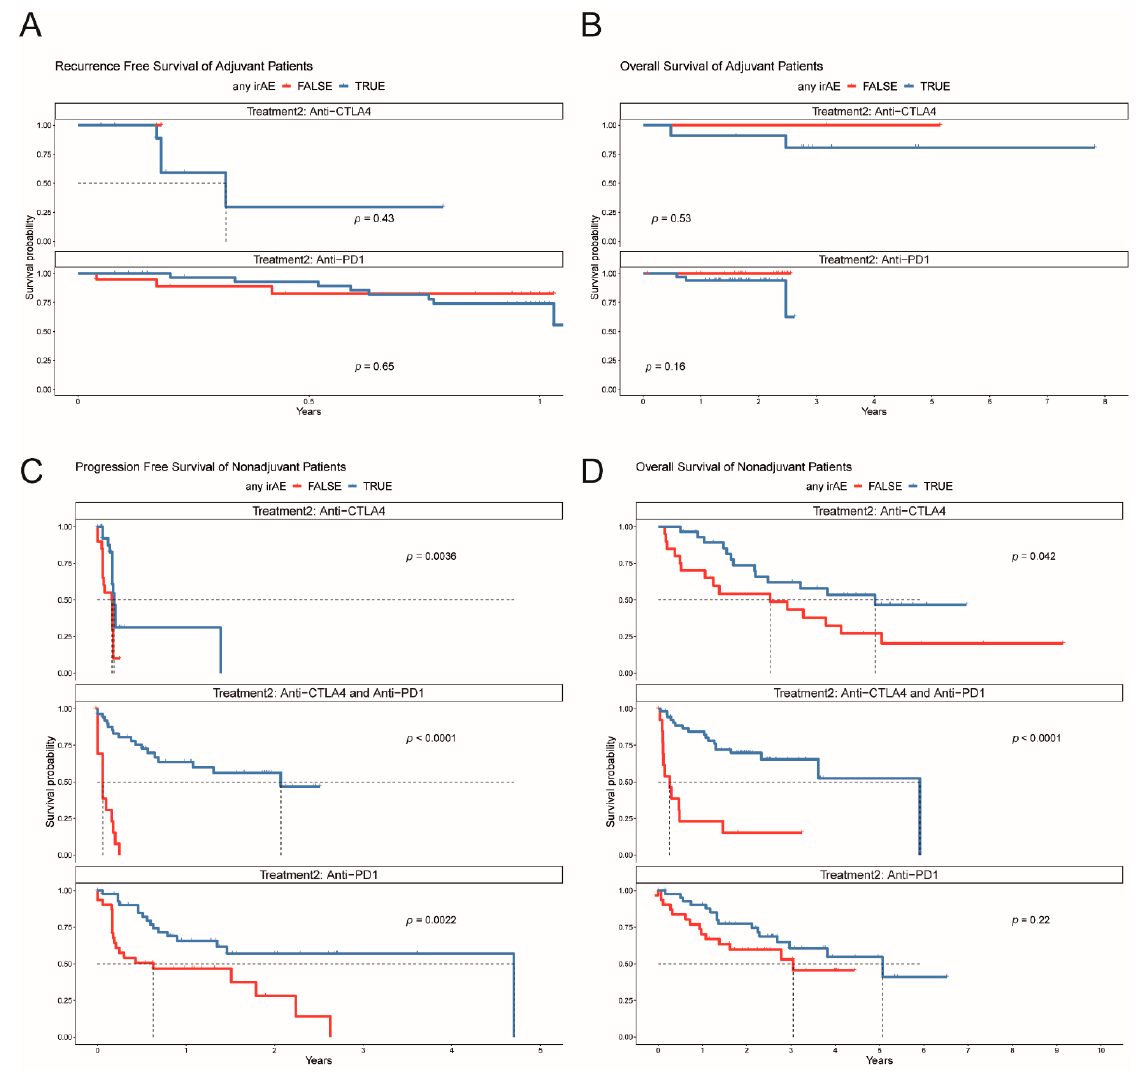
Figure 4. Kaplan–Meier plots for the adjuvant and non-adjuvant setting stratified by the appearance of irAE. ( A ) Recurrence-free survival for anti-CTLA4 and anti-PD1 in the adjuvant setting. ( B ) Overall survival for anti-CTLA4 and anti-PD1 in the adjuvant setting. ( C ) Progression-free survival for anti-CTLA4, anti-PD1, and anti-CTLA4 with anti-PD1 in the non-adjuvant setting. ( D ) Overall survival for anti-CTLA4, anti-PD1, and anti-CTLA4 with anti-PD1 in the non-adjuvant setting.